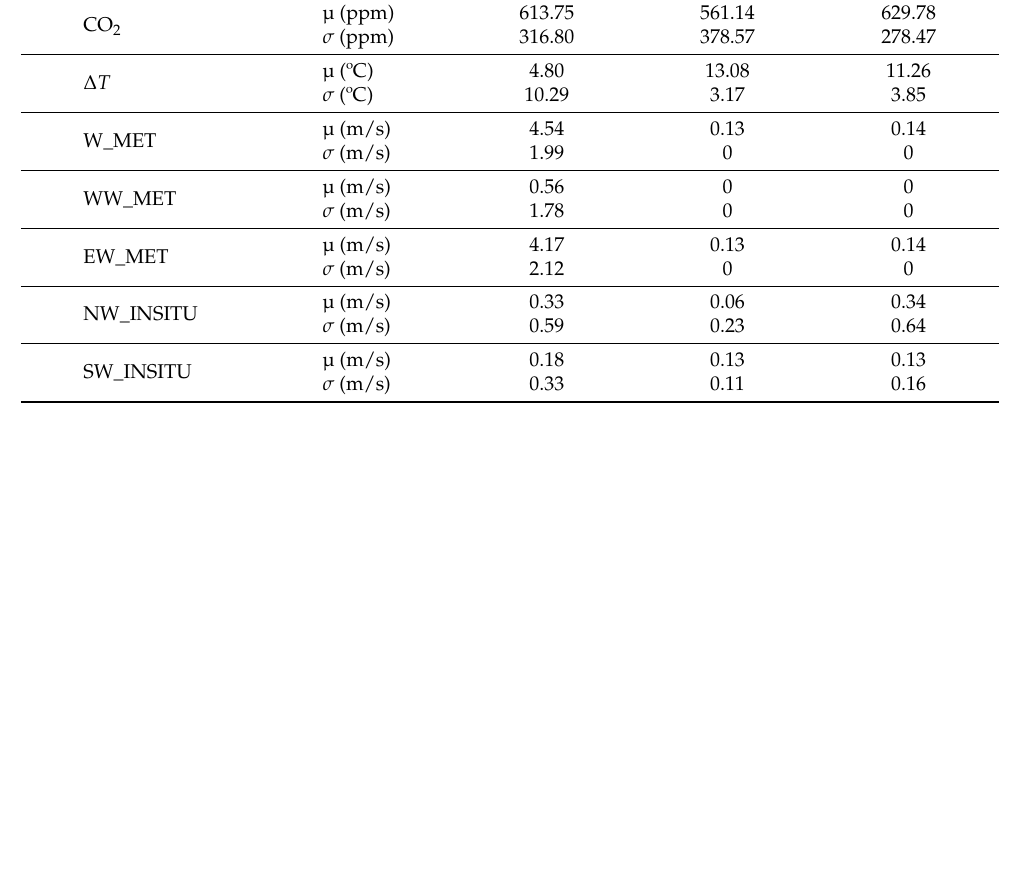
Table 1. Mean (µ) and standard deviation ( σ ) values of each measured data for each period.